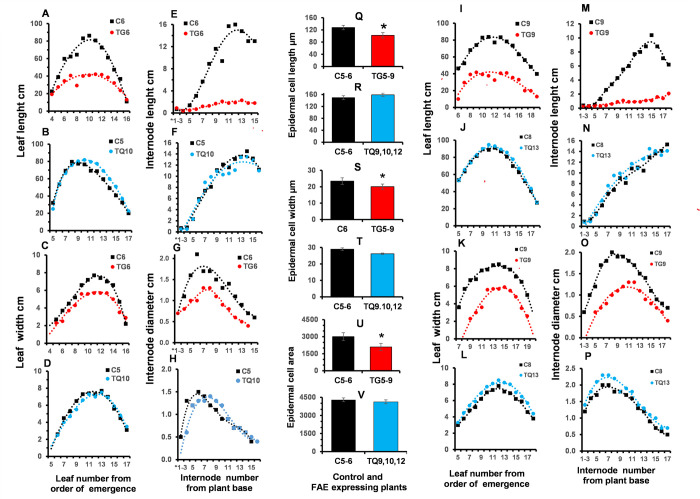
Leaf, internode and epidermal cell morphology of two FAEA expressing TG and TQ plants at the VT developmental stage.Leaf length (A,B,I,J), maximum leaf width (C,D,K,L), internode length (E,F,M,N) and internode diameter (G,H,O,P), average epidermal cell length (Q,R), width (S,T) and area (U,V) of the abaxial epidermis of fully expanded leaves of control and apoplast FAEA expressing plants TG6 (A,E,C,G), TG9 (I,M,K,O), TQ10 (B,F,D,H) and TQ13 (J,N,L,P), and corresponding control plants (C6,C5,C8,C9) at the VT developmental stage. Mean ± seem (n = 10 replicates of 10 sections per sample, 1cm from the leaf tip, in rows adjacent to the leaf midrib) of plants TG 5–9, TQ9,10 and 12 and controls C5-6. * indicate significant differences (Tukey’s a = 0.001) among means.